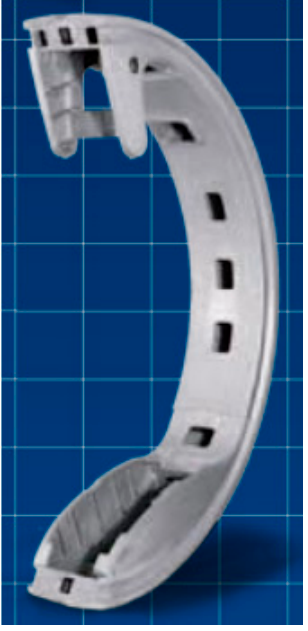
Figure 2. Electrical connector model.